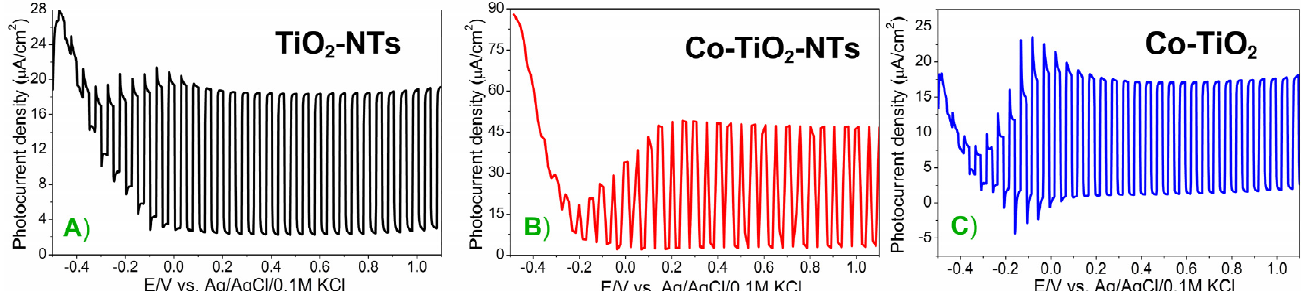
Figure 10. The linear sweep voltammetry curves obtained at a sweep rate 50 mV·s − 1 for samples ( A ) TiO 2 -NTs (black line), ( B ) Co-TiO 2 -NTs (red line), ( C ) Co-TiO 2 (blue line) in the 0.1 M K 2 SO 4 aqueous electrolyte. Source of light: 150 W xenon lamp equipped with an AM1.5 filter, light intensity: 100 mW·cm 2 .